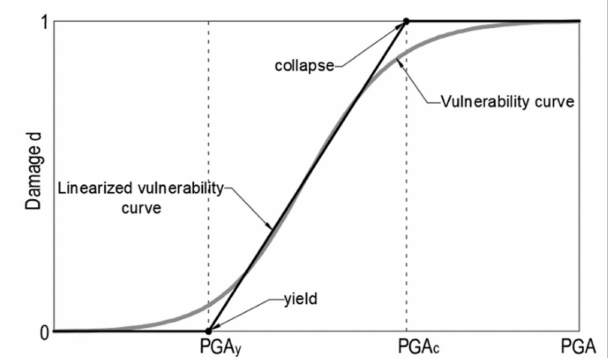
Figure 10. Vulnerability curve and its idealization.